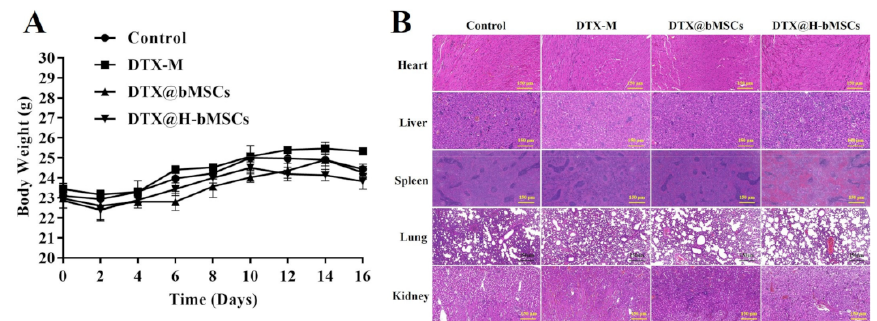
Figure 11. Safety and biocompatibility evaluation. Body weight of mice in each group ( A ); histolog- ical characterization of the heart, liver, kidney, and spleen tissues obtained from mice of different treatment groups ( B